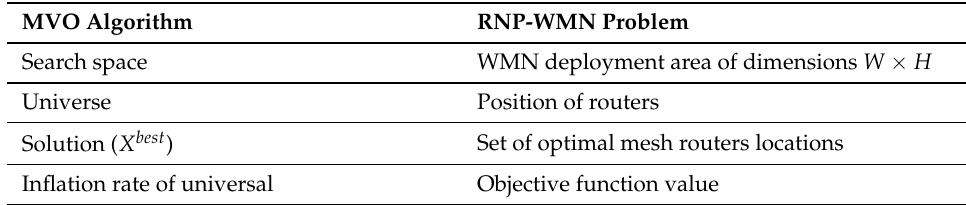
Table 2. Settings of the MVO algorithm for the RNP-WMN problem.